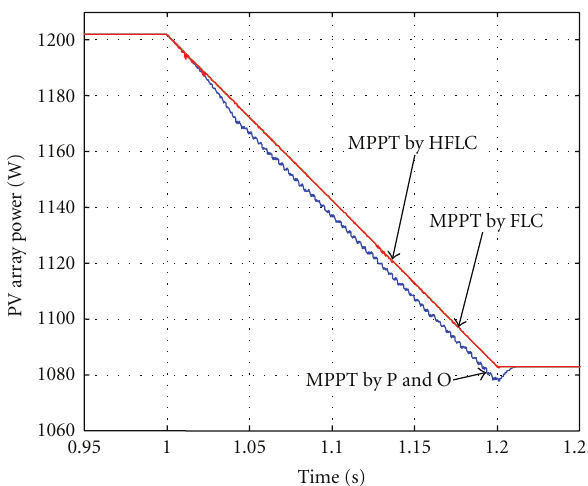
Figure 15: PV output power under slow irradiation change from 1000 W/m 2 to 900 W/m 2 .